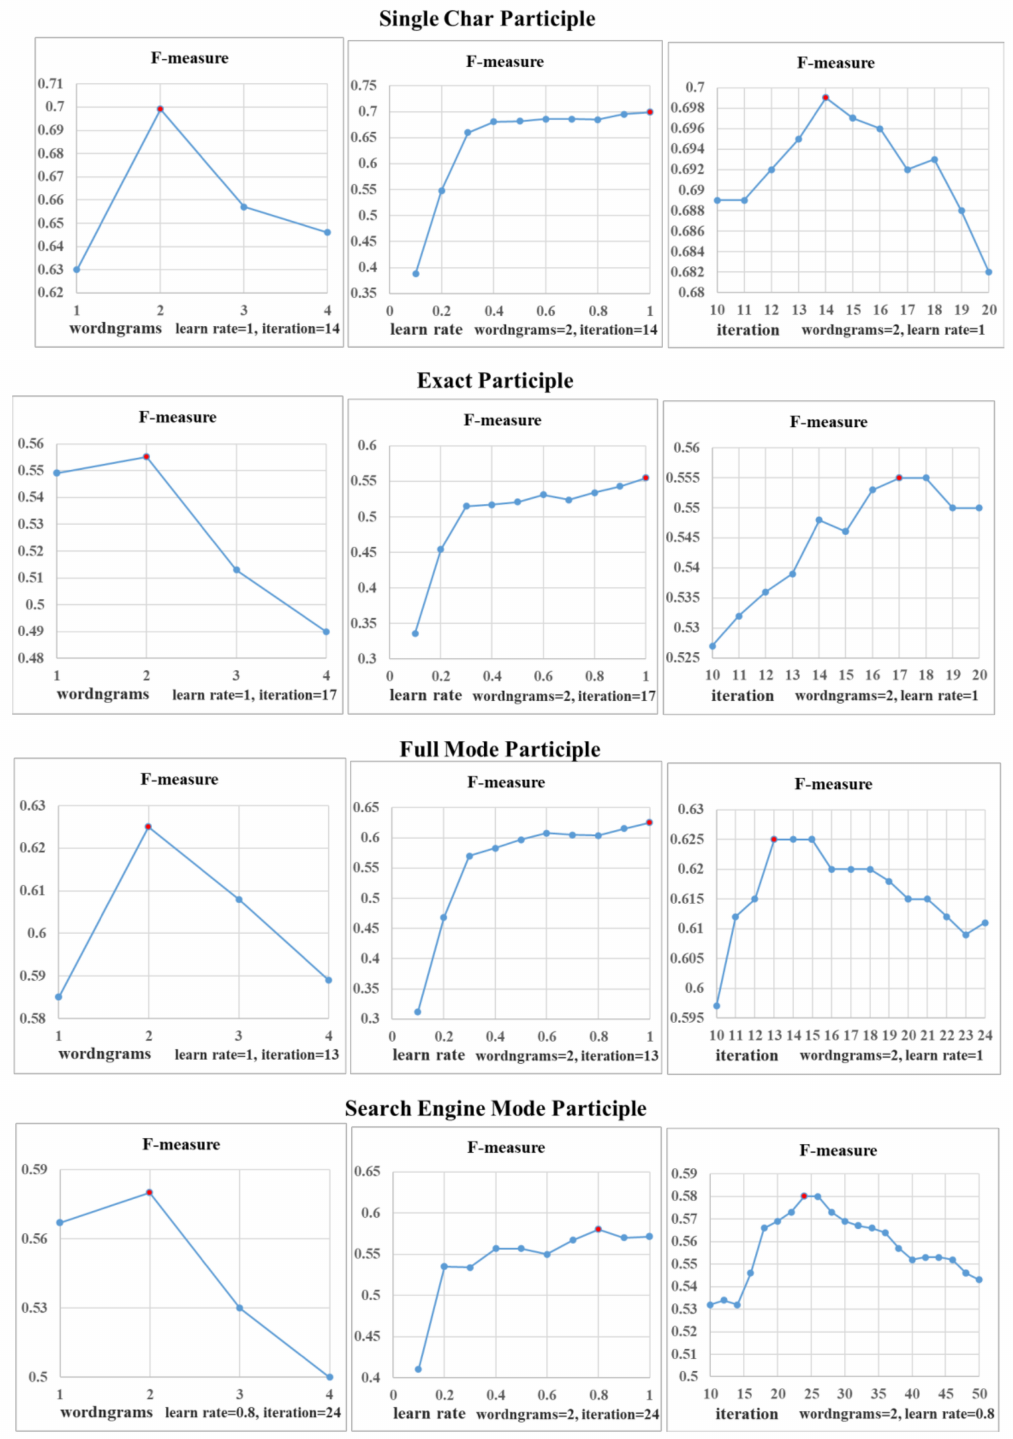
Figure 4. Parameter sensitivity analysis of text